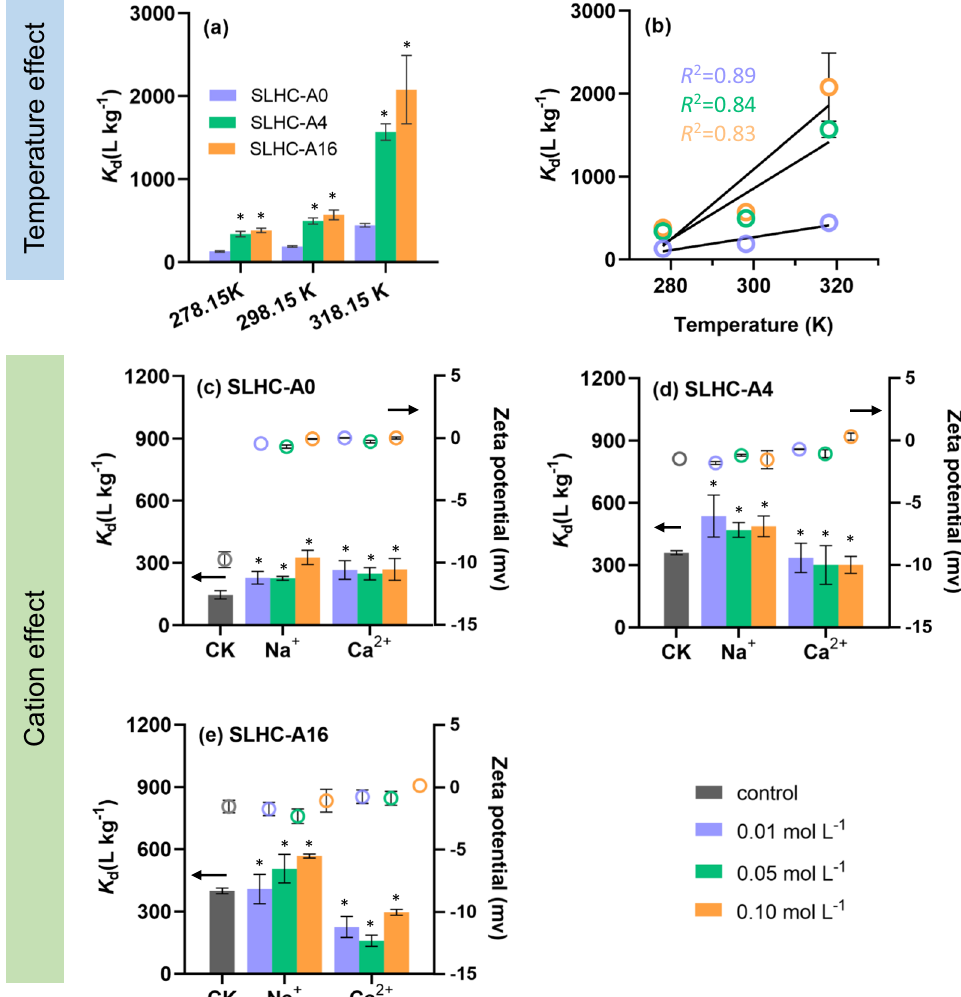
Fig. 4 Effect of temperature on the Cd sorption ( a ) and their linear regression curve ( b ); effect of coexisting cations on the Cd sorption (histogram) and zeta potential (scatter diagram) to fresh and aged sludge-derived hydrochar. c SLHC-A0, fresh sludge-derived hydro- char. d SLHC-A4, 4-month aged sludge-derived hydrochar. e SLHC-